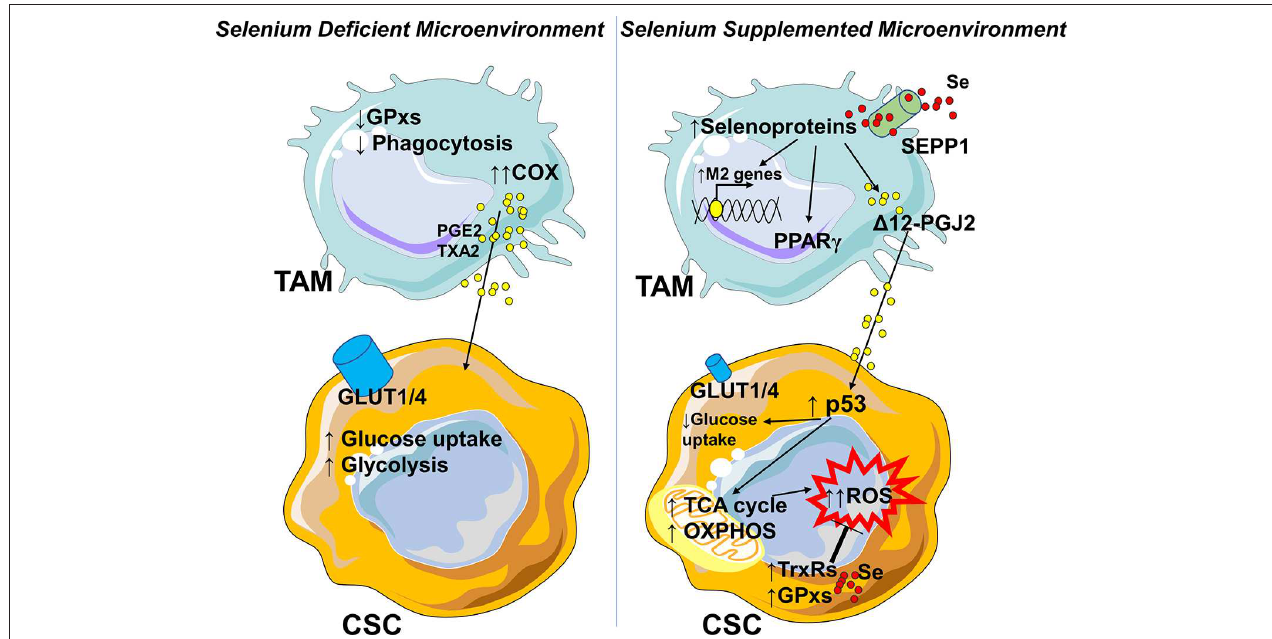
FIGURE 4 | Selenium availability in the tumor microenvironment influences the phenotype of macrophages. In a Se-deficient microenvironment TAMs lose glutathione dependent peroxidases (GPxs) and phagocytic activities (M1-like feature) toward transformed cells and produce PGE2 and TXA2 from arachidonic acid by cyclooxygenase (COX) supporting the highly glycolytic cancer stem cells (CSC). In the presence of selenium, TAMs rely on selenium importer SEPP1, and increase the selenoproteins which in turn polarize the macrophages toward an M2-like phenotype, with activation of PPAR γ , degradation of pro-inflammatory PGE2, and production of 1 12-PGJ2. 1 12-PGJ2 activates the tumor suppressor protein p53, which in turn upregulates the TCA cycle and oxidative phosphorylation and lowers glucose uptake by the cells. As a compensatory mechanism the antioxidant machinery (selenium dependent thioredoxin reductases TrxRs and glutathione peroxidases GPxs) is enhanced but the increase is not sufficient to control ROS production. In a Se-rich microenvironment, its lower uptake might be assumed as one of the mechanisms through which neoplastic cells modulate M2-like macrophages and/or sustain TAMs function. In parts the figures are based on speculations and have been prepared by assembling in-house built cellular metabolic pathway outlines with a modified and adapted version of BioRender images.